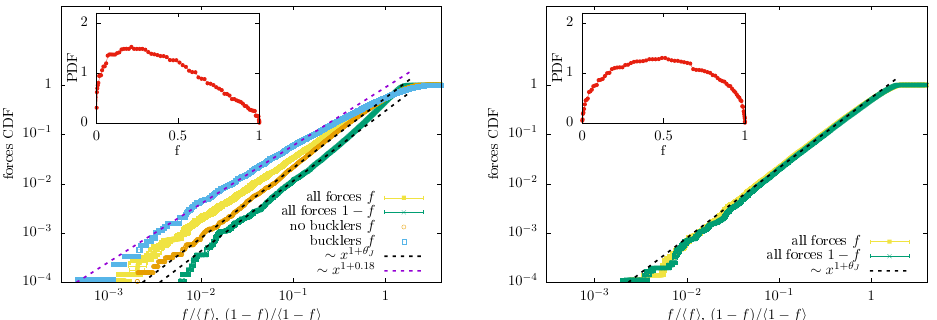
Figure 4: Contact force distributions. Left panel : the cumulative of the contact force distribution at φ = 0.85 in 2 d , close to the unjamming transition. We plot the cumu- lative both starting from the edge at f = 0 and at f = 1. While a blind statistics of forces is controlled by a hybrid power law exponent, once the effects of bucklers are removed we clearly observe power laws controlled by the mean field exponents, both close to f = 0 + and f = 1 − . In the inset we plot the empirical probability distribution function. Data produced with system size N = 512, dimensions d = 2, averaged over 30 samples. Right panel : Cumulative distribution of contact forces close to zero and one at φ = 2 in 2 d , far from jamming. We observe that both distributions follow the mean field exponent. Our statistics is not sufficient to detect any localized excitations at this packing fraction and therefore in this case we consider directly all forces with- out separating the contribution of bucklers from the analysis. Data produced with system size N = 512, dimensions d = 2, averaged over 35